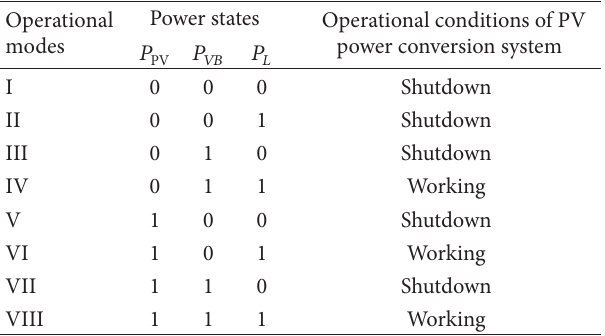
Table 1: Operational conditions of PV arrays for the proposed con-